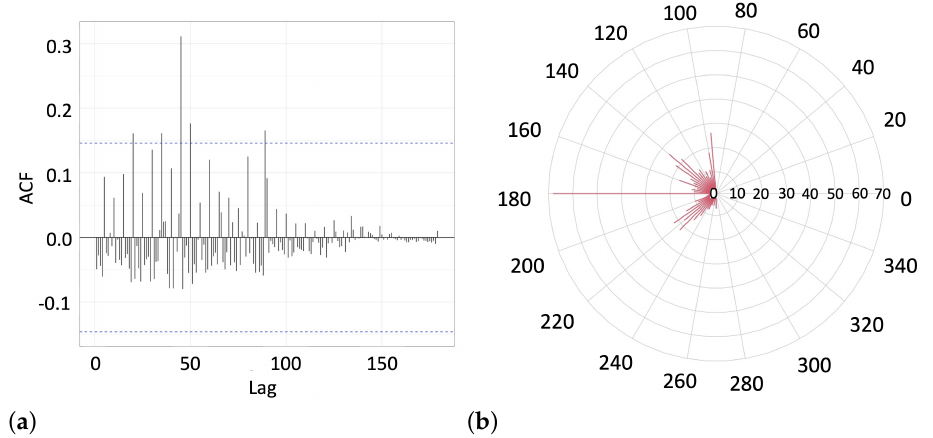
Figure 11. ( a ) The autocorrelation function (10) of the angle lags between the sequential lines observed in the group of participants in Experiment 3. The dashed horizontal line marks the level of statistically significant correlations. ( b ) The radial histogram (not normalized) of the line-drawing angles observed in the third